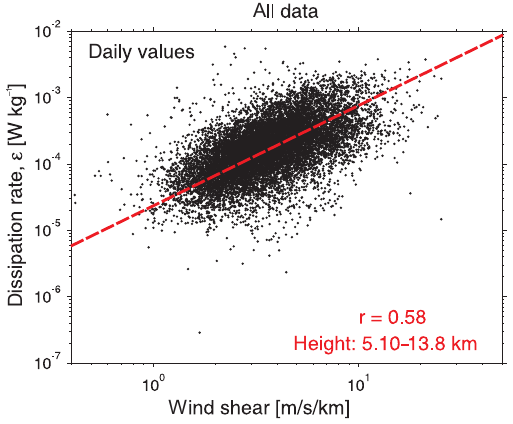
Figure 17. Same as Fig. 15, but for the results derived based on all the data with 1-day resolution in the years 2010–2013 at altitudes of 5.1–13.8km. The corresponding correlation coefficient r is indi- cated in the lower right corner, which is highly significant, i.e. well above the 99.9%